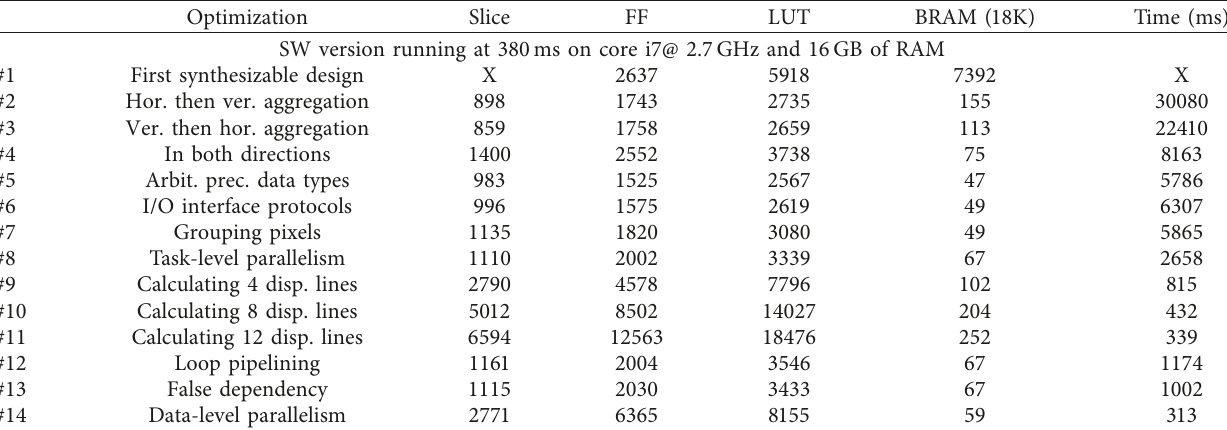
Table 1: Synthesis results for each optimization